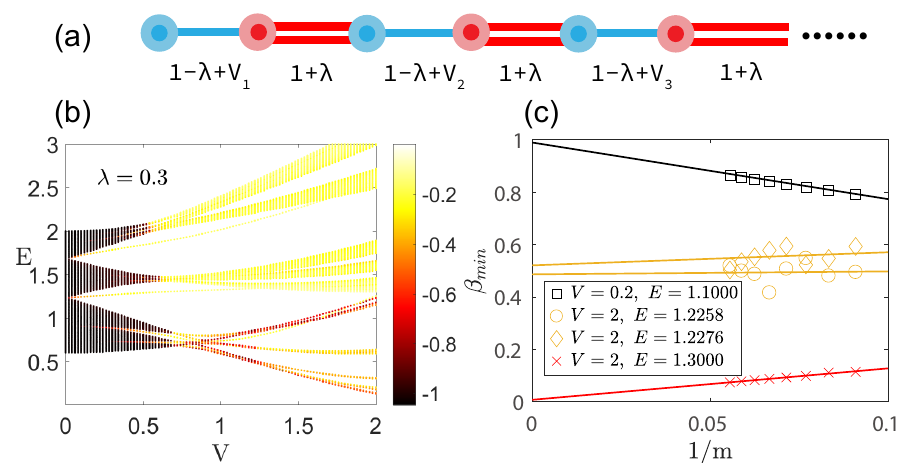
Figure 3: (a) Cartoon picture of the quasiperiodic Su-Schrieffer-Heeger chain. The blue and red spheres represent the sublattices A and B, respectively. The b - a n − 1 n = 1 + λ , with λ the dimerization strength, bond has a uniform hopping amplitude t n = 1 − λ + V the a - b bondis modulated quasi-periodically, t (cid:48) . (b) Opposite of the IPR n n n n scaling exponent, − τ , versus potential amplitude V and eigen energy E . (c) Minimal exponent β of individual eigenstates in the three phases (localized, extended, and min critical) as a function of the inverse Fibonacci index 1 / m for the various potential strengths V and energies E